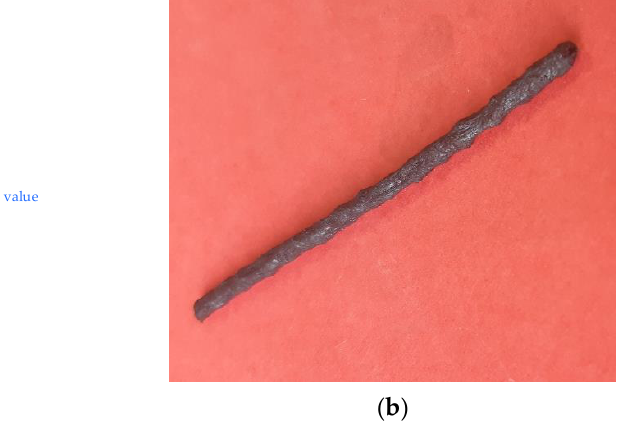
Table 3. Recycled fibre general properties.